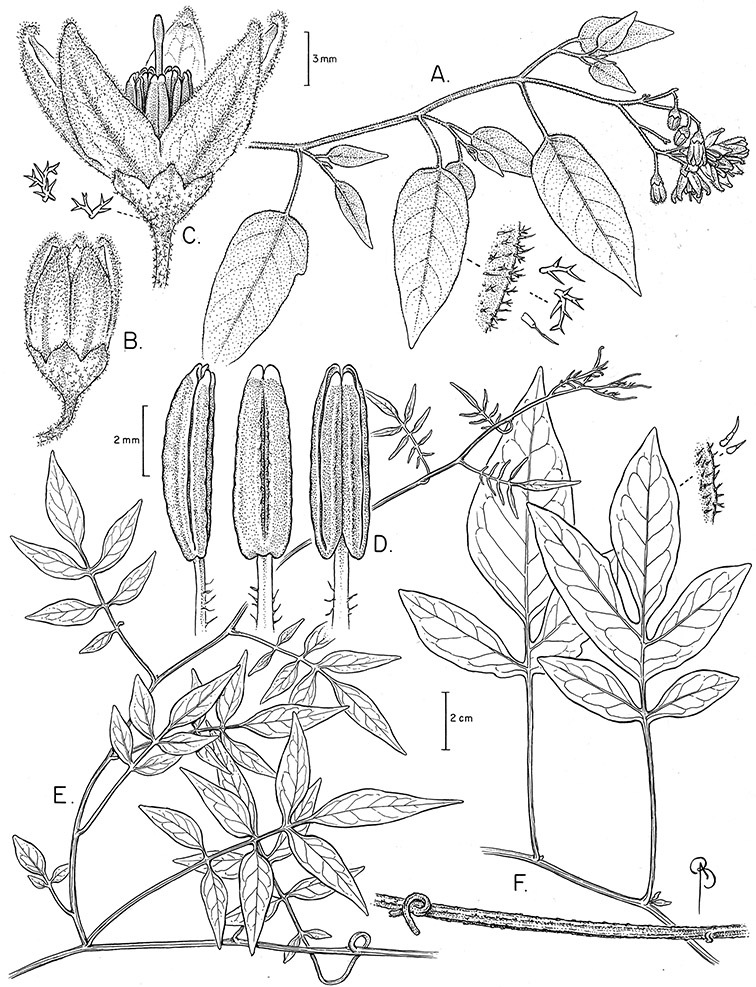
Solanum calileguae Cabrera.(A–D drawn from Nee & Bohs 50809
E drawn from Nee & Bohs 50768). Illustration by Bobbi Angell.